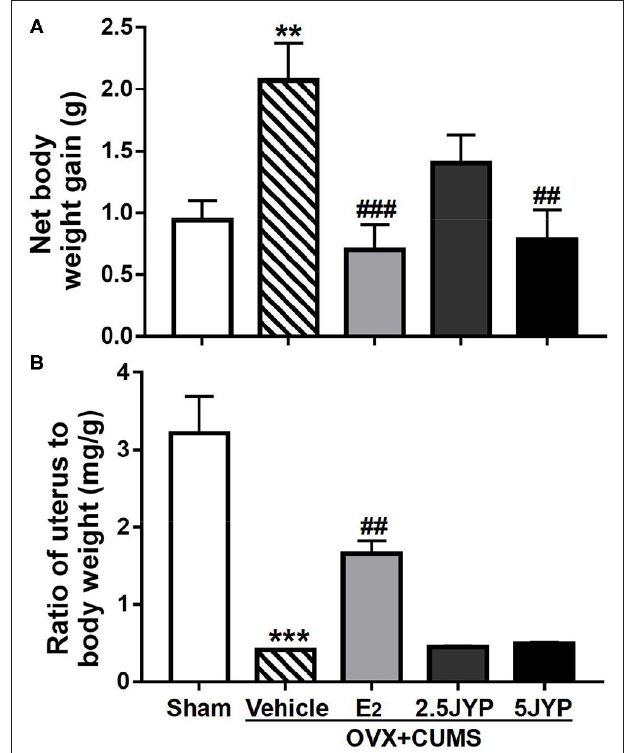
FIGURE 2 | Effects of 2.5 g/kg JYP (2.5 JYP), 5.0 g/kg JYP (5 JYP), and 0.3 mg/kg estradiol (E2) on net changes in body weight (A) and ratio of uterus